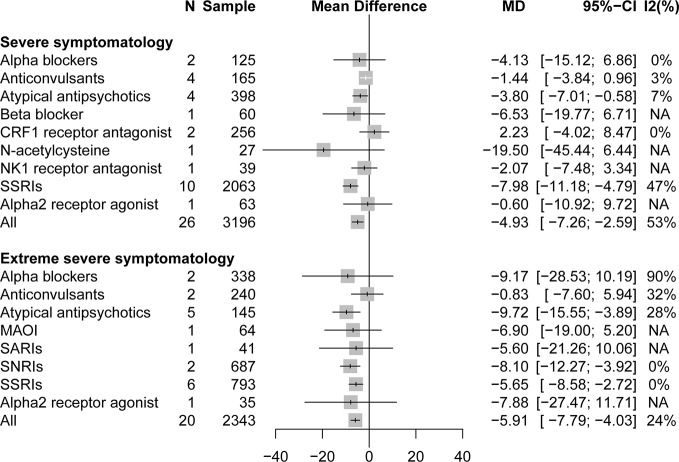
Forest plot based on stratified analyses of severity of trauma based on CAPS scores of placebo-controlled comparisons. MAOIs, monoamine oxidase inhibitors; NK1, neurokinin-1 receptor antagonist; SARIs, serotonin antagonist and reuptake inhibitors; SNRIs, serotonin and norepinephrine reuptake inhibitors; SSRIs, selective serotonin reuptake inhibitors; NA, not applicable.